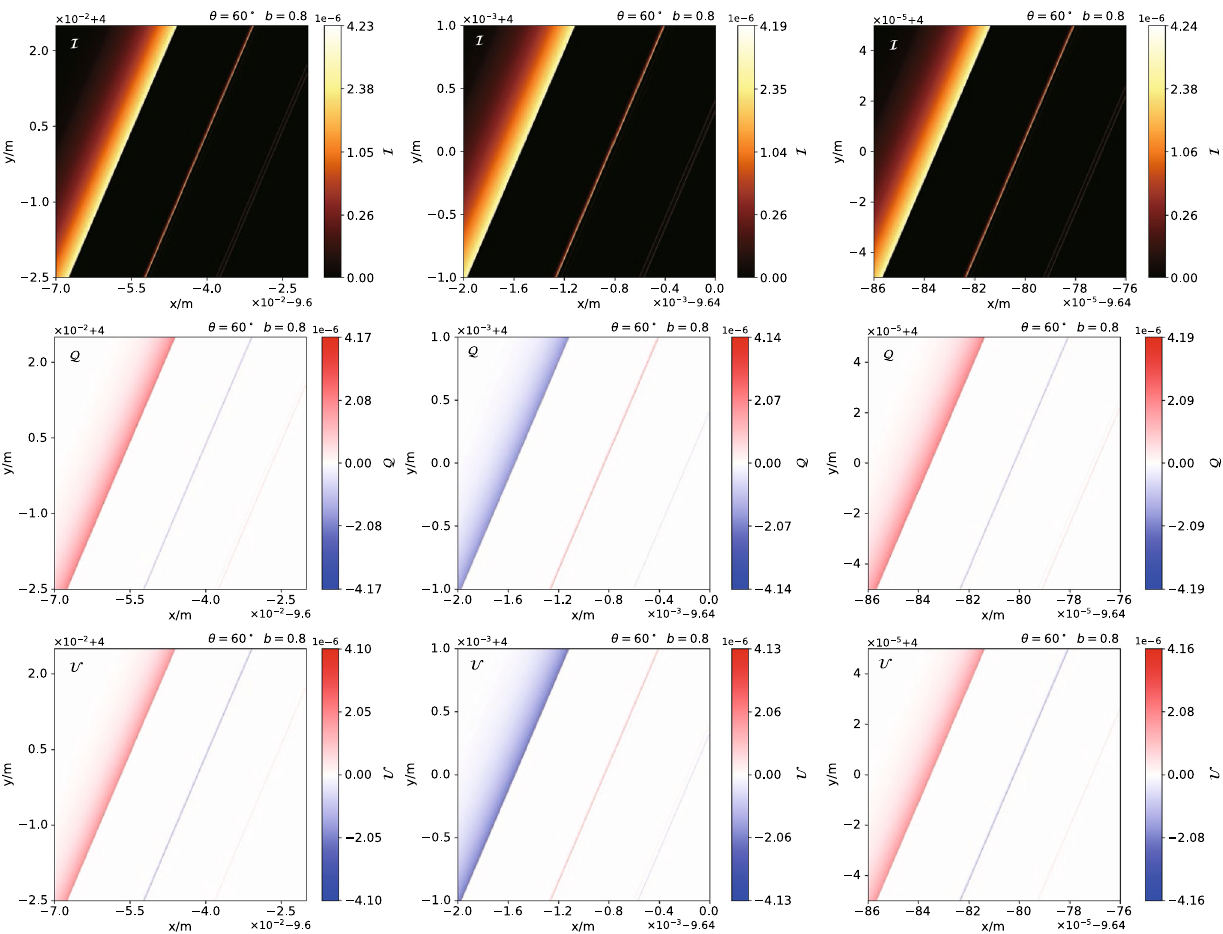
Fig. 10 Enlarged image of Q and U near secondary image with θ 0 = 60 ◦ and b = 0 . 8. In each rows, the right panel is local magnification of the left